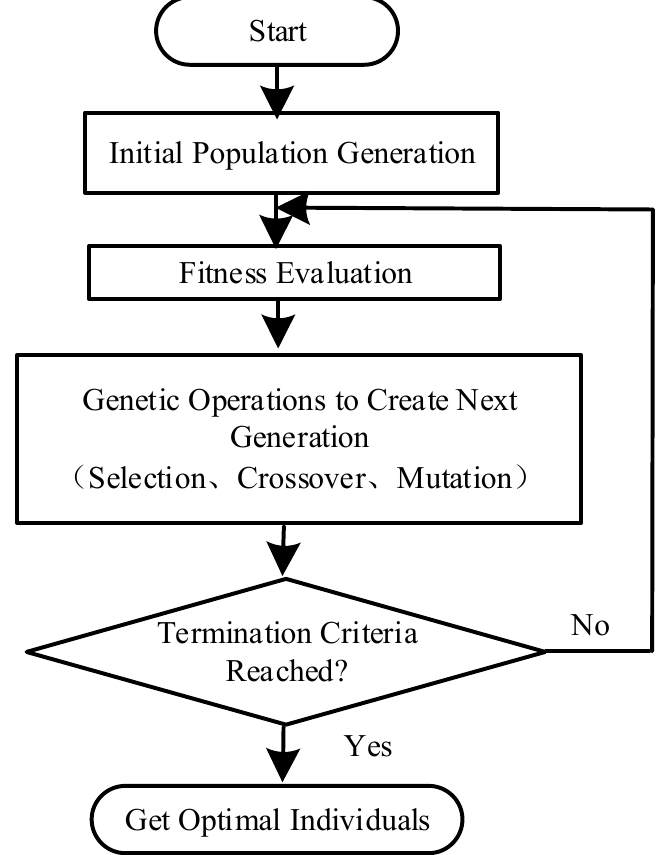
Figure 5. The flowchart of the genetic algorithm.